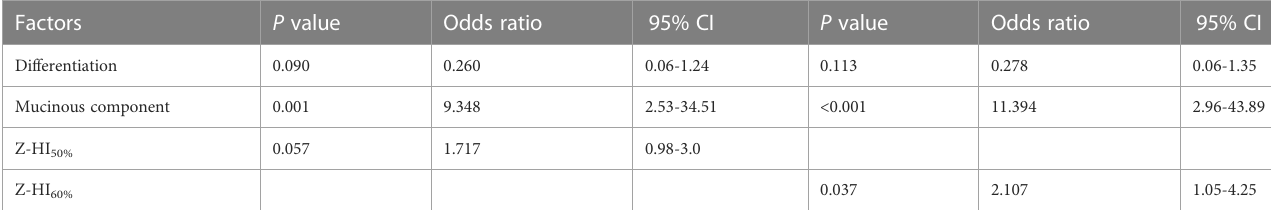
TABLE 3 Multivariate regression analyses for predicting MSI in CRC.